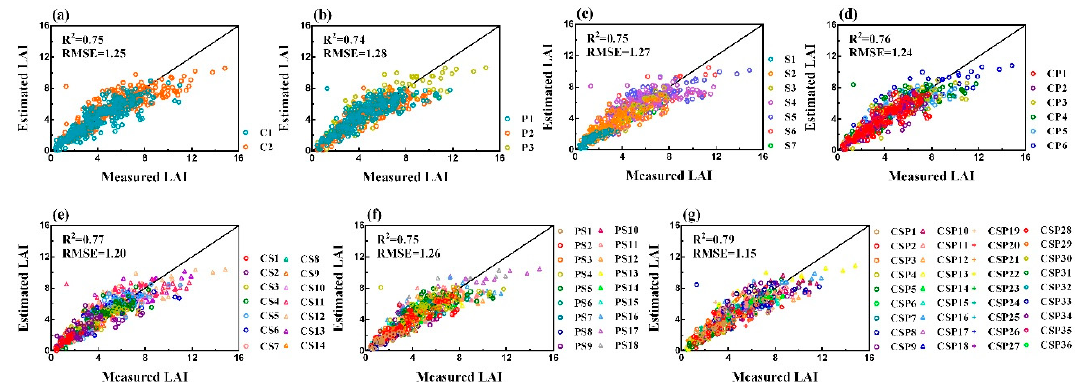
Figure 11. Comparison of LME models (for LAI estimation) with different random effects: ( a ) C, cultivar, ( b ) P, planting pattern, ( c ) S, growth stage, ( d ) CP, combination of cultivar and planting pattern, ( e ) CS, combination of cultivar and growth stage, ( f ) PS, combination of planting pattern and growth stage and ( g ) CSP, combination of cultivar, growth stage and planting pattern. C1-2, P1-3, S1-7, CP1-6, CS1-14, PS1-18 and CSP1-36 represent the groupings of corresponding random e ff ects, respectively.